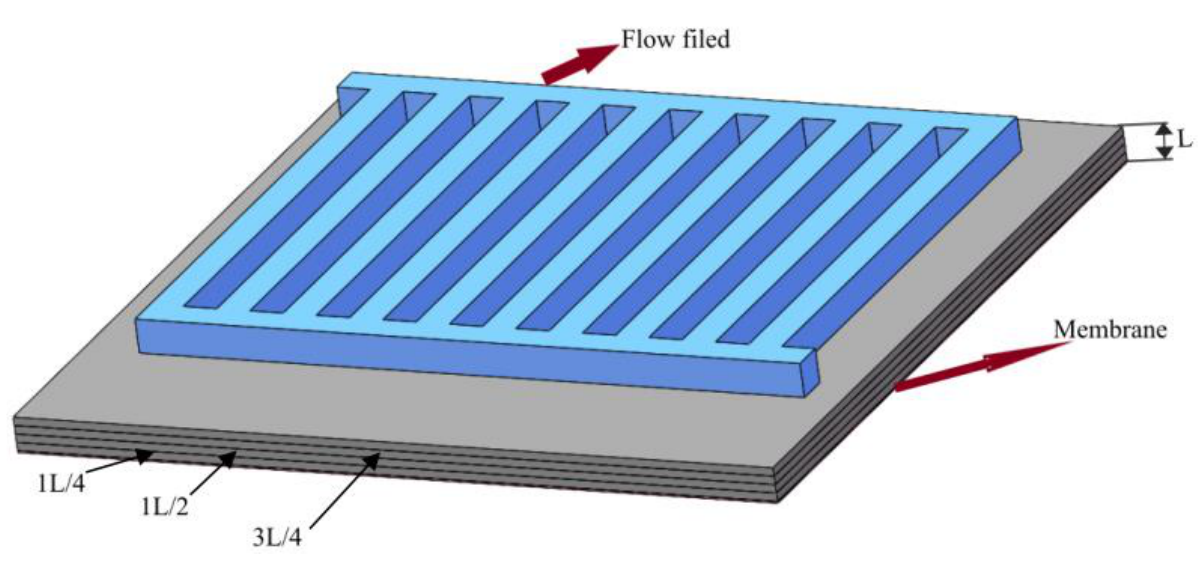
Figure 7. Diagram of the electrode sections.